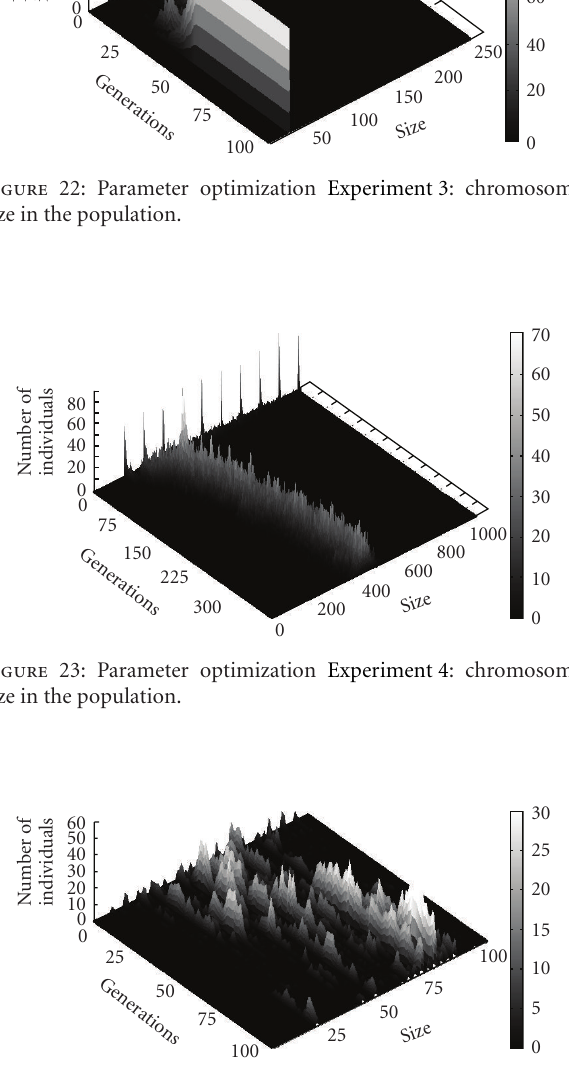
Figure 24: Parameter optimization Experiment 5: chromosome size in the